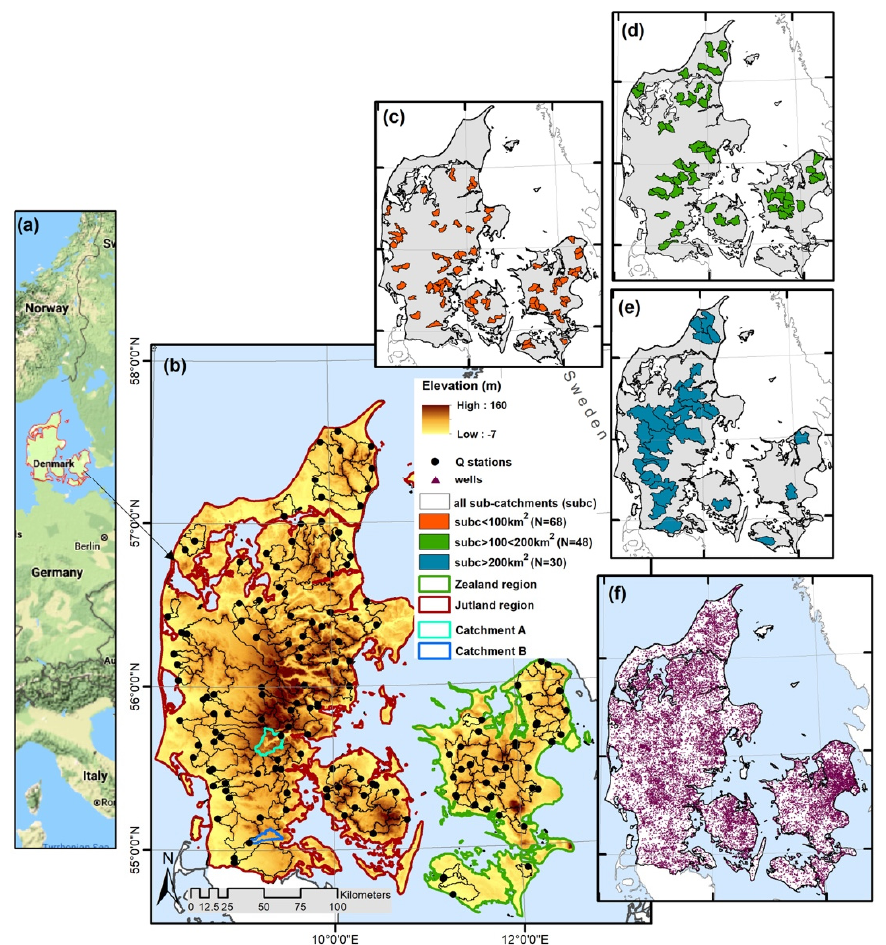
Figure 1. Overview of the study area: ( a ) the geographical location of Denmark in northern Europe, ( b ) distributions of the selected 146 runoff gauges (Q stations) and two main administrative regions of Denmark with underlying topography, ( c ) sub-catchments (subc) smaller than 100 km 2 , ( d ) subc between 100 and 200 km 2 , ( e ) subc larger than 200 km 2 , and ( f ) a number of 25,981 hydraulic head observation wells used in the national water resource model of Denmark (DK-model) setup for modeling the groundwater flows.